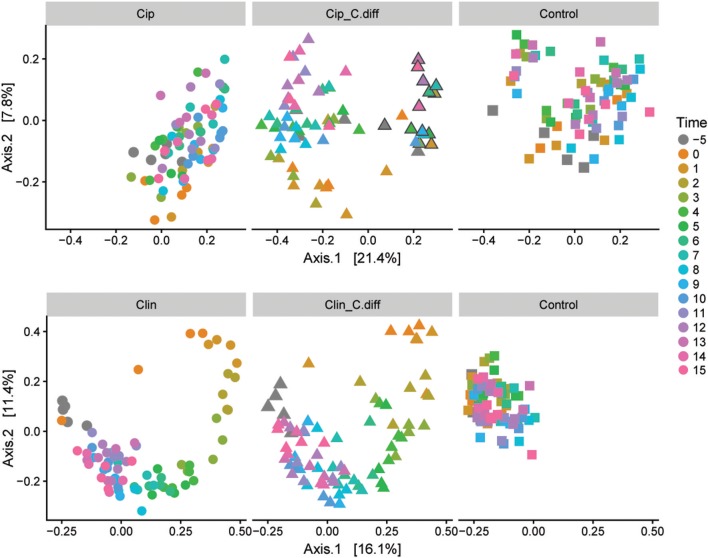
Microbial community responses to treatments. Separate Bray-Curtis PCoA ordinations of microbial community dynamics of Ciprofloxacin (Top) and Clindamycin (Bottom) treated pigs over time. Each ordination is faceted by treatment: antibiotic (left), antibiotic+ C.difficile (middle), and control (right). Gray outlines in the Cip. C.diff treatment surround samples from a single animal which exhibited a differing response.